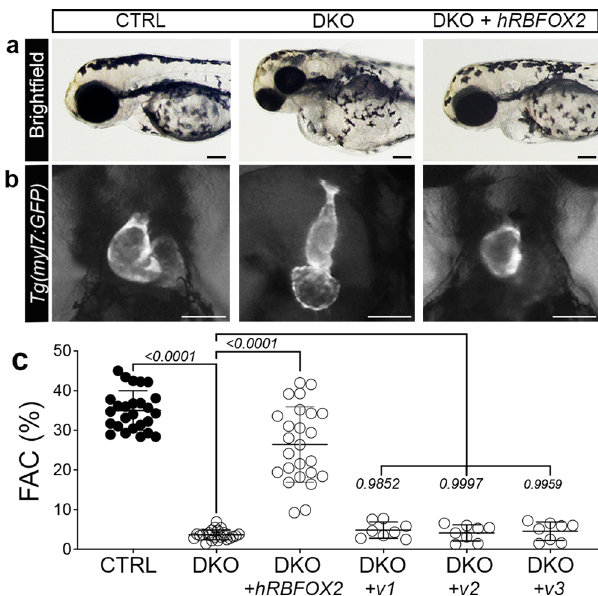
Fig.7|Injectionofhuman RBFOX2 mRNArestorescardiovasculardevelopment in rbfox -de fi cient zebra fi sh, while HLHS-linked RBFOX2 variants fail to rescue. a Bright fi eldimagesof72hpfCTRL,DKO,andDKOembryosinjectedwithwildtype human RBFOX2 ( hRBFOX2 ) mRNA. b Bright fi eld images with fl uorescent overlay of Tg(myl7:GFP) reporter signal in hearts of 72hpf CTRL, DKO, and DKO embryos injected with wildtype hRBFOX2 mRNA. c Dot plot showing % FAC of 72hpf ven- tricles in the following cohorts: uninjected CTRL, uninjected DKO, DKO+ wildtype hRBFOX2 , DKO+ RBFOX2-v1, v-2, or v-3 mRNA where hRBFOX2 harbors a variant (v) previously discovered in patients with HLHS. Sample sizes and statistics: ( c ) unin- jectedCTRL, n =26;uninjectedDKO, n =23;DKO+wildtypehuman RBFOX2 , n =25; DKO+ hRBFOX2 v1, v2 , or v3 ( n =8 per group). Each dot represents 1 embryo. Data arepresentedasmeanvalues+/ − oneSD.Statisticalsigni fi cancewasdeterminedby ordinary one-way ANOVA Dunnet ’ s multiple comparisons test. P values are shown. Source data are provided as a Source Data fi le. Scale bars: 20 μ